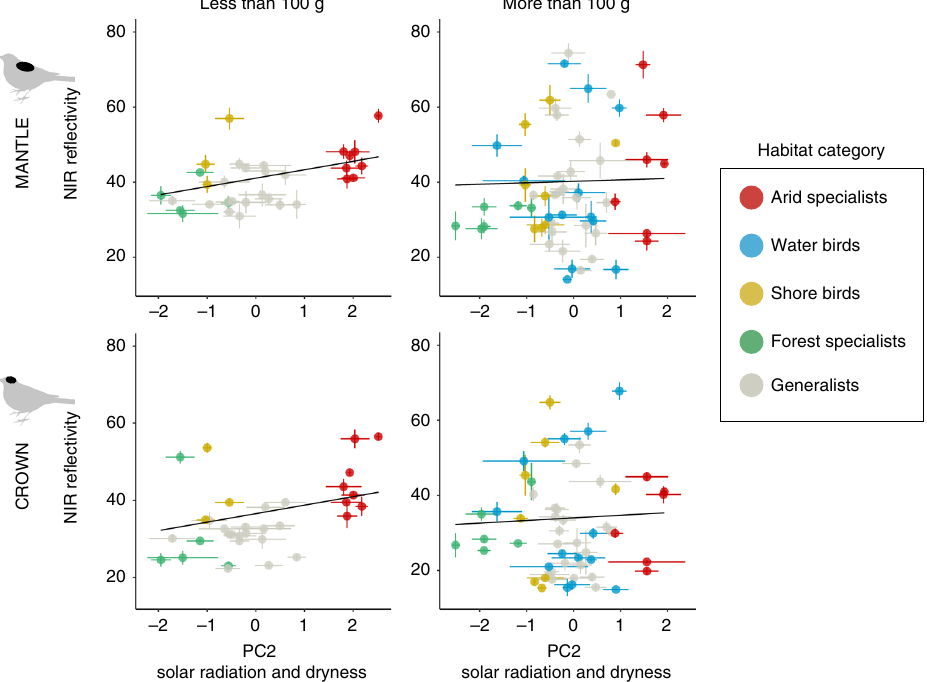
Fig. 2 Relationship between NIR re fl ectivity and climate for the mantle and crown. The data are separated by the arbitrary size of 100 g (<100 g: left panels, 33 species; >100 g: right panels, 57 species) to facilitate visualisation of the interaction between environmental PC2 and body mass, but body mass was treated as a continuous variable in statistical analyses. Each point represents the average value per species and the standard error in both axes; colour represents the species ’ habitat. Trend lines were predicted using a phylogenetically controlled model that included environmental PCs, UV-visible re fl ectivity and a random phylogenetic